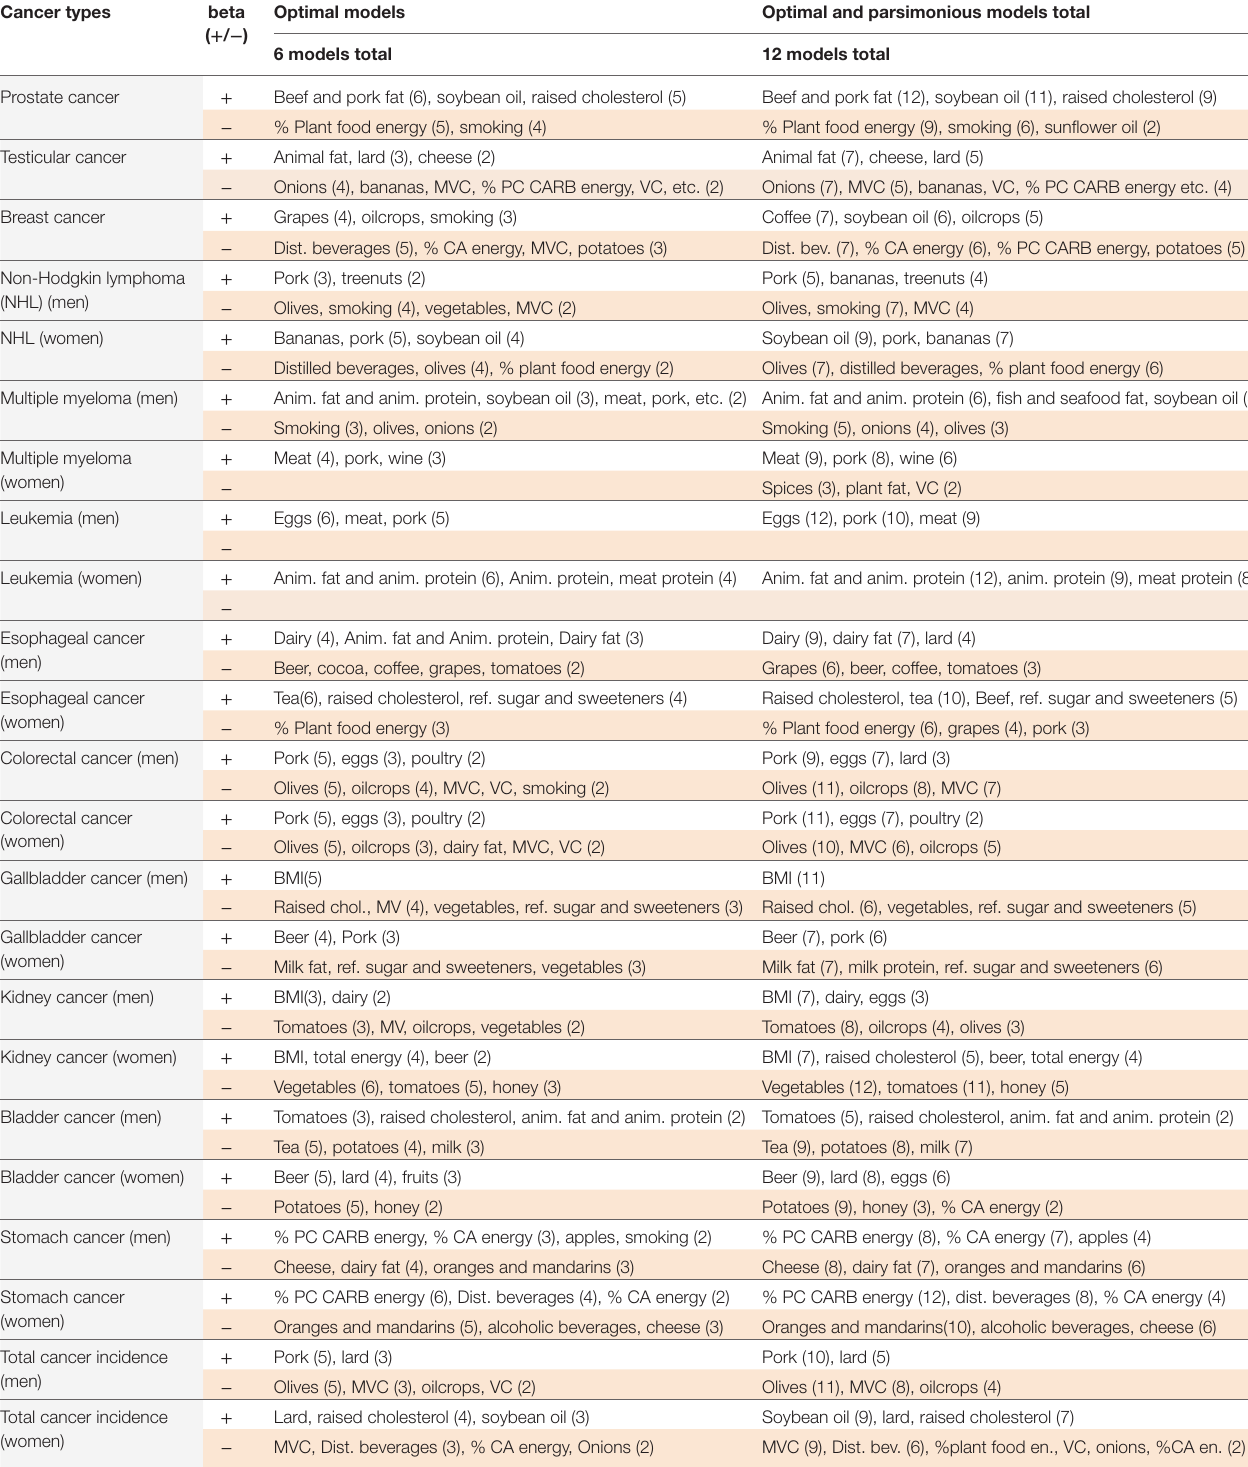
Table 3 | Frequency of variables that appeared among top 5 with the highest absolute beta coefficients, in 12 models of the ridge regression, LASSO regression, and elastic net regression. cancer